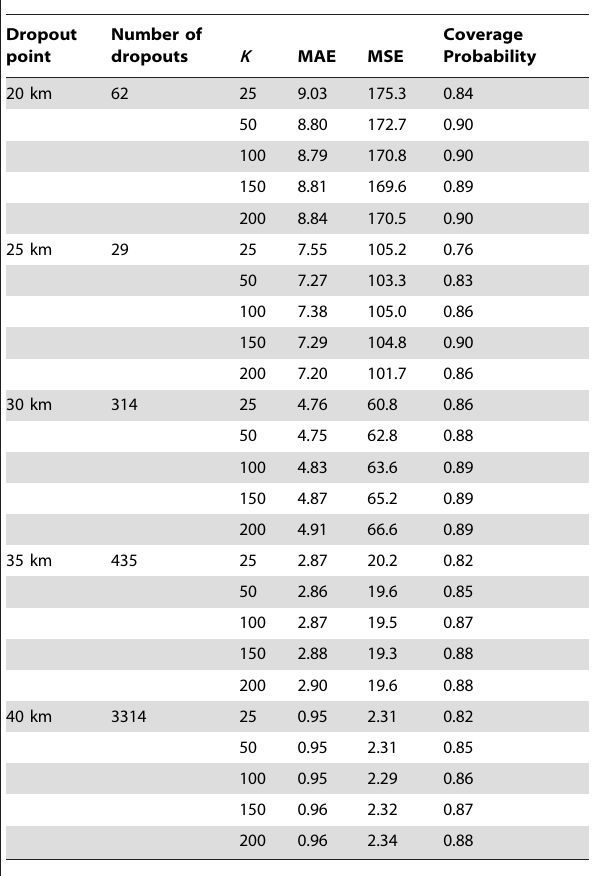
Table 8. Properties of the rescaled KNN procedure.